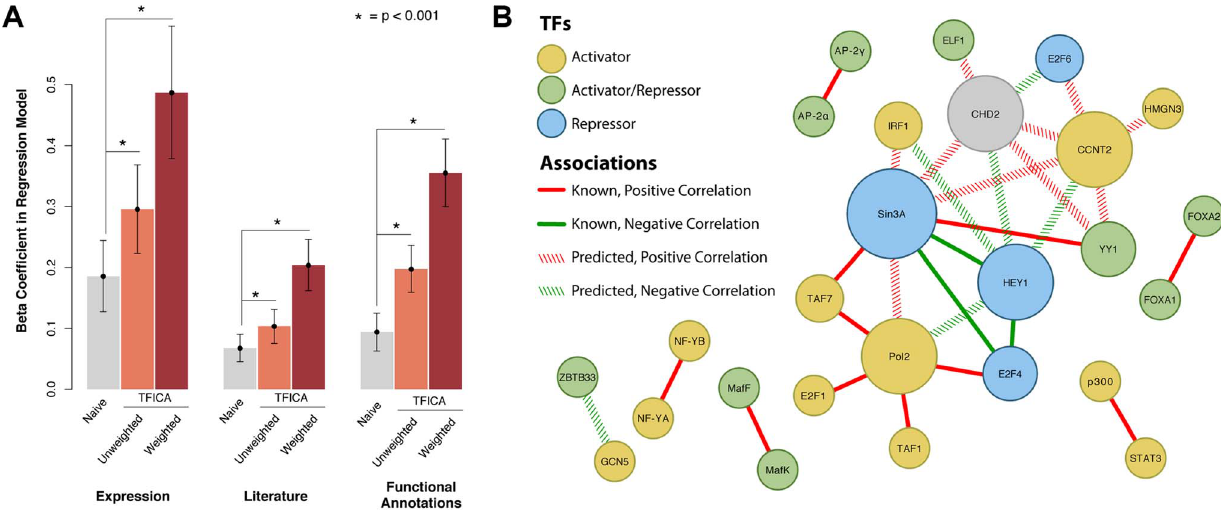
Figure 3. Predicting TF-TF interactions using shared modules as a measure of shared function. (A): Prediction of (i) gene expression correlation, (ii) literature mentions, and (iii) shared functional annotations using a Naive approach, shared TFICA modules, and weighted TFICA modules. The Naive approach (‘‘Naive’’) links TFs to TFs by the similarity of their ChIP-Seq targets, ‘‘TFICA’’ links TFs to TFs by the similarity of their significantly associated modules, and weighted TFICA weights these modules in the similarity by their confidence. b coefficients in a linear model are shown with 95% confidence intervals. In each case, TFICA and weighted TFICA significantly outperforms the Naive approach. In addition, we used permutation testing to validate these results. In each case (expression, literature, function) the b coefficient for the permuted model was not significant ( b exp =0.16; 95%CI 2 0.02–0.34; b lit = 2 0.02 95%CI 2 0.08–0.05; b fun = 2 0.04 95%CI 2 0.14–0.06, P . 0.05 for each). Data not drawn. (B): The top 30 highest-scoring pairs are shown, as measured by target module similarity, 14 of which are known associations (solid lines). Many of these factors form a tight sub-network of activators and repressors.